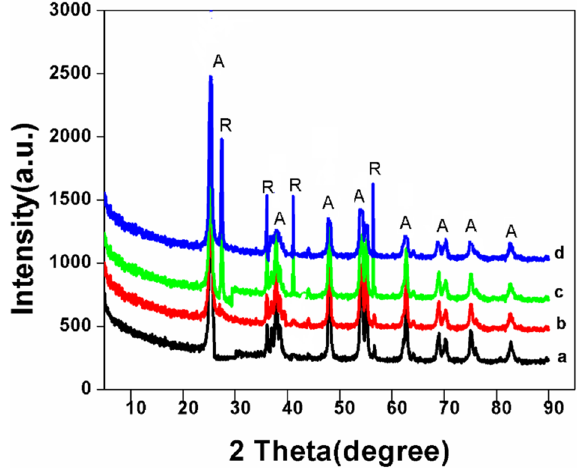
Figure 2. XRD patterns of ( a ) NT ( b ) NT1 ( c ) NT2, ( d )